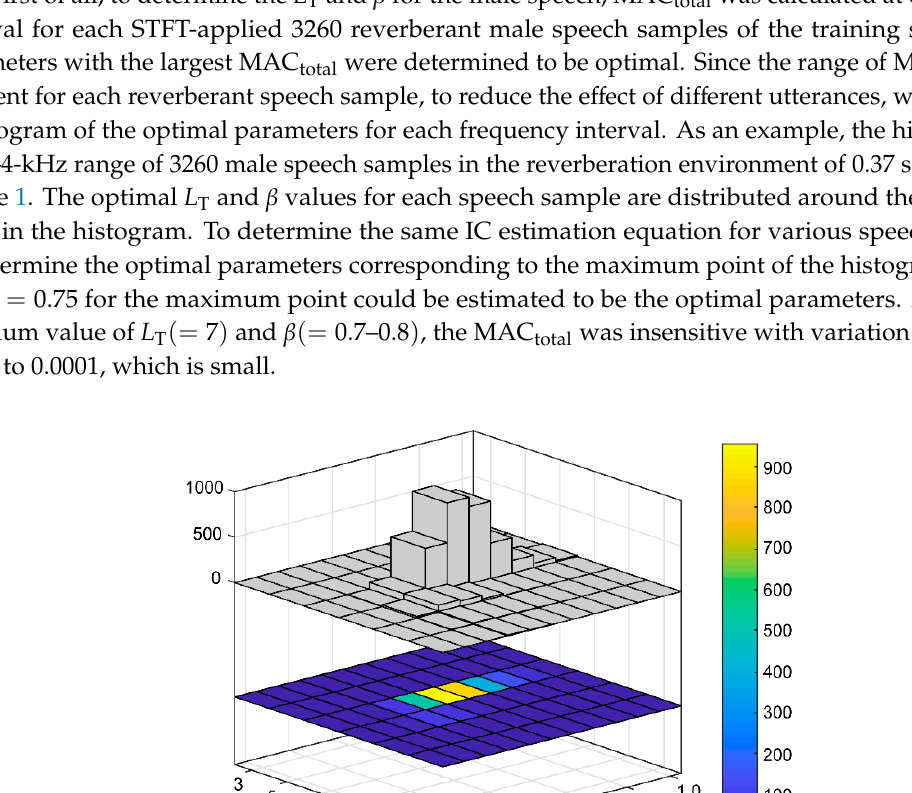
Figure 1. Histogram of 3260 reverberant male speech samples for L T and β at 3 kHz to 4 kHz in RT 60 = 0.37 s based on mean accuracy of coherence (MAC total ).